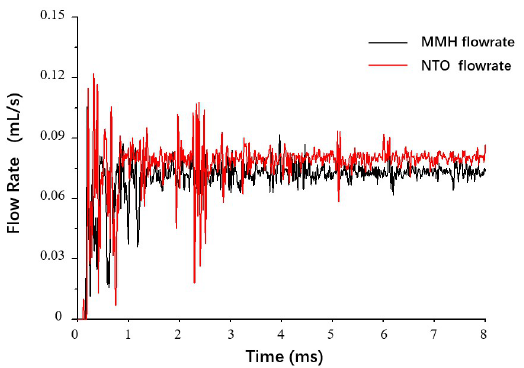
Figure 5. Comparison of flowrate fluctuation between MMH and NTO, with downstream orifice plate at 0.5 m/s switch speed and 0.25 mm stroke.